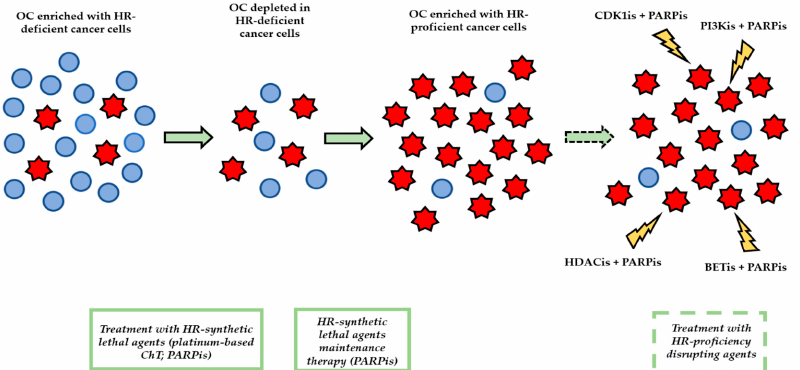
Figure 4. Ovarian cancer (OC) tumor evolution under treatment with HR-synthetic lethal agents and new insights into novel therapeutic approaches aiming at disrupting HR proficiency in OC. Legend. Blue circle: HR-deficient ovarian cancer cell; Red star: HR-proficient ovarian cancer cell; OC: Ovarian Cancer; HR: Homologous Recombination; ChT: Chemotherapy; PARPis: Poly (ADP Ribose) Polymerase Inhibitors; CDK1is: Cyclin-Dependent Kinase 1 inhibitors; PI3Kis: PhosphoInositide 3-Kinase inhibitors; BETis: Bromodomain and Extraterminal Domain inhibitors; HDACis: Histone DeACetylase inhibitors.